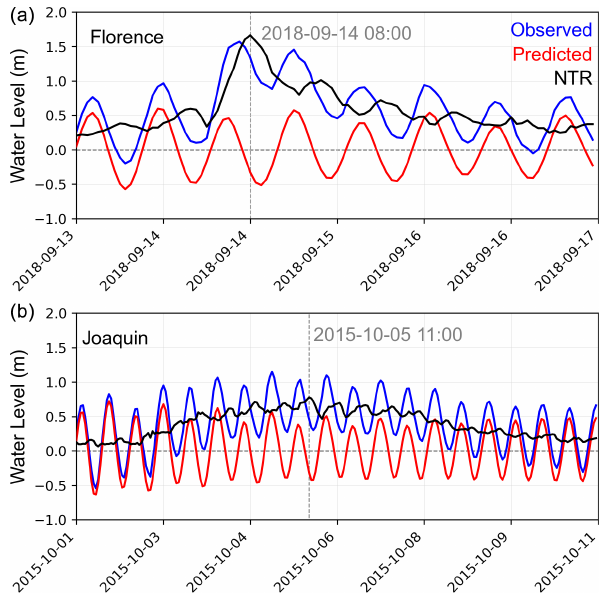
Figure 6. Hydrographs for Hurricane Florence (a) and Tropical Storm Joaquin (b) showing observed water levels (blue), predicted water levels (red), and the non-tidal residual (NTR, black). The timing of peak surge for each storm is highlighted by the vertical dashed line.